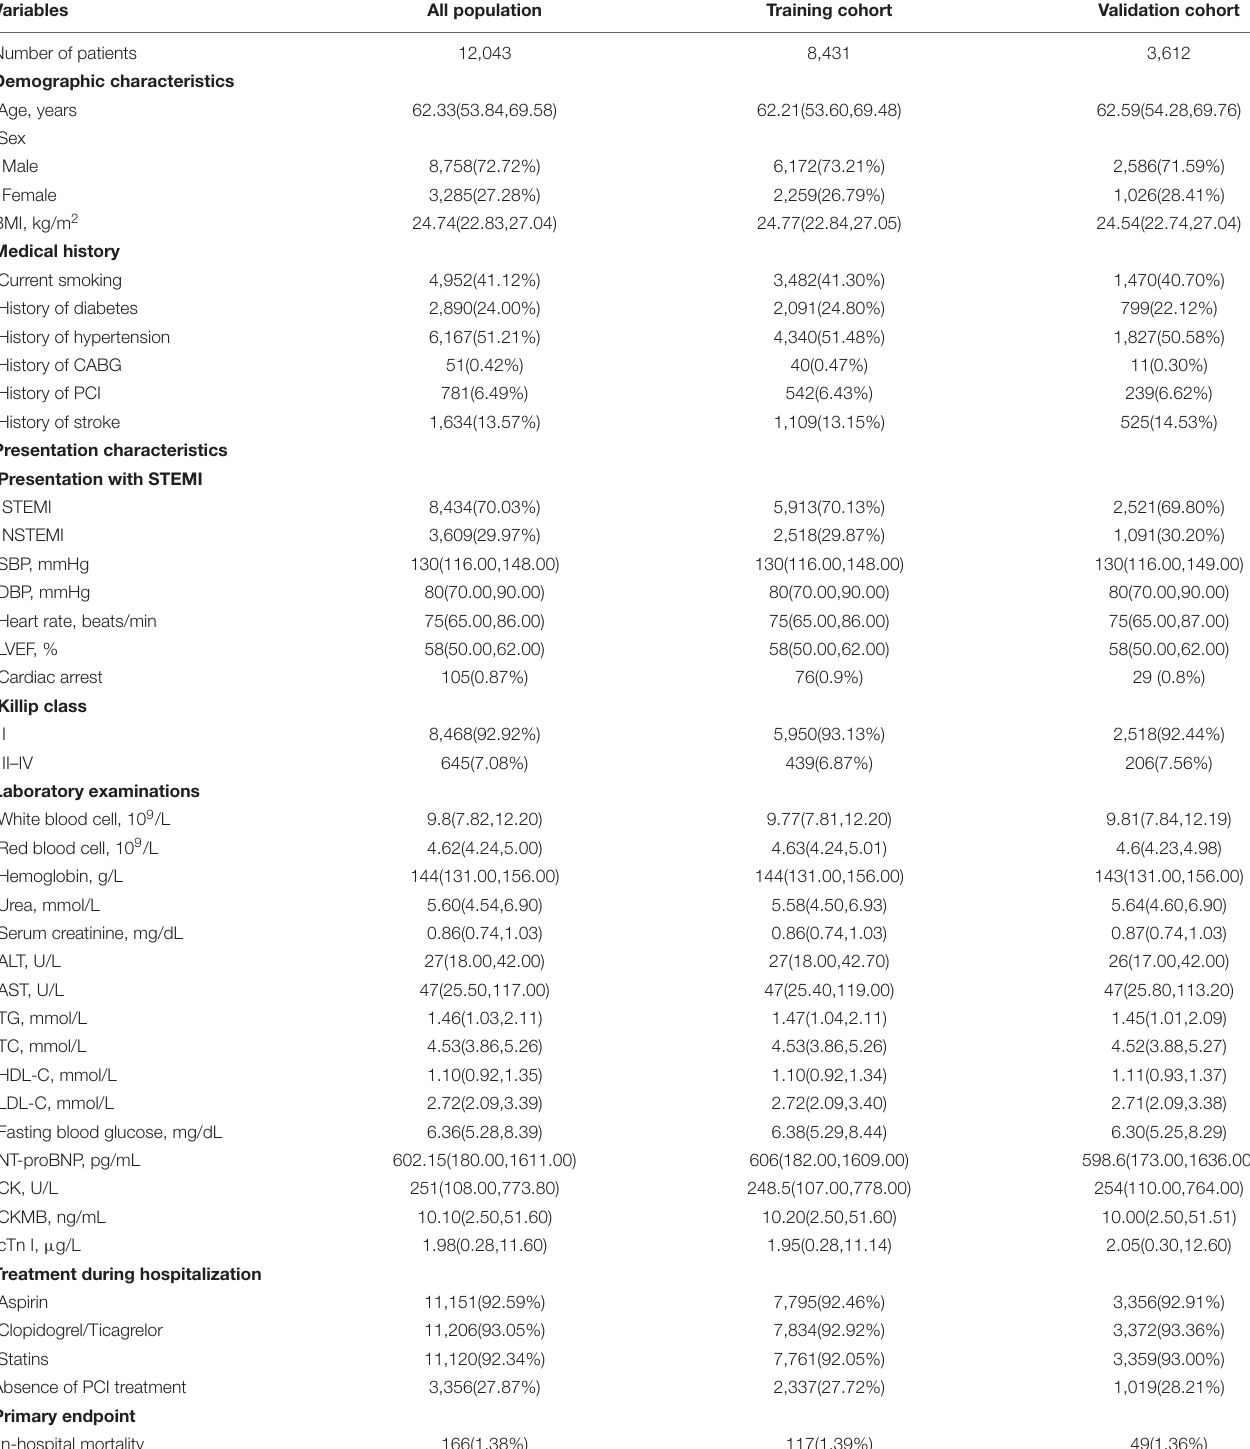
TABLE 1 | Characteristics of baseline in the training and validation